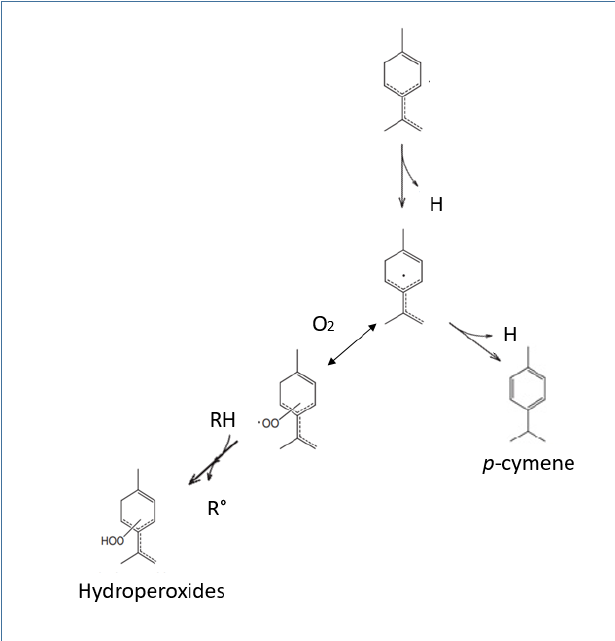
Figure 3. Oxidation of terpenoids adapted from Reference [95].